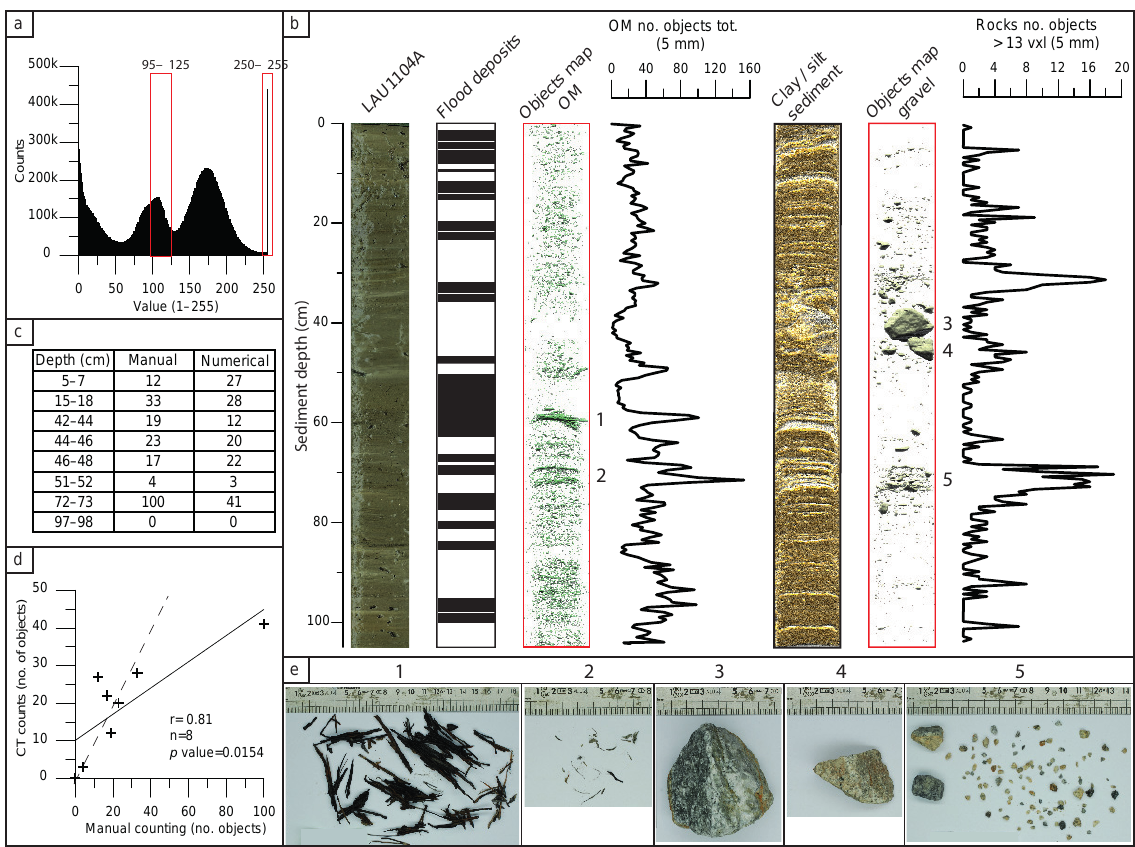
Figure 3. (a) Number of counts histogram for 1 to 255 levels of grey; selected range for OM (95–125) and for gravels (240–255) shown in red. (b) From left to right: core LAU1104A photography, position of flood deposits, CT image stacks of both rocks and OM and corresponding totals summed at 5mm intervals. (c) Selected depth for comparison between manual and numerical counts in core LAU1104A. (d) Correlation between manual and numerical rock counts (solid line); CT counts: manual counts (dashed line). (e) Photographs of organic matter (e1,